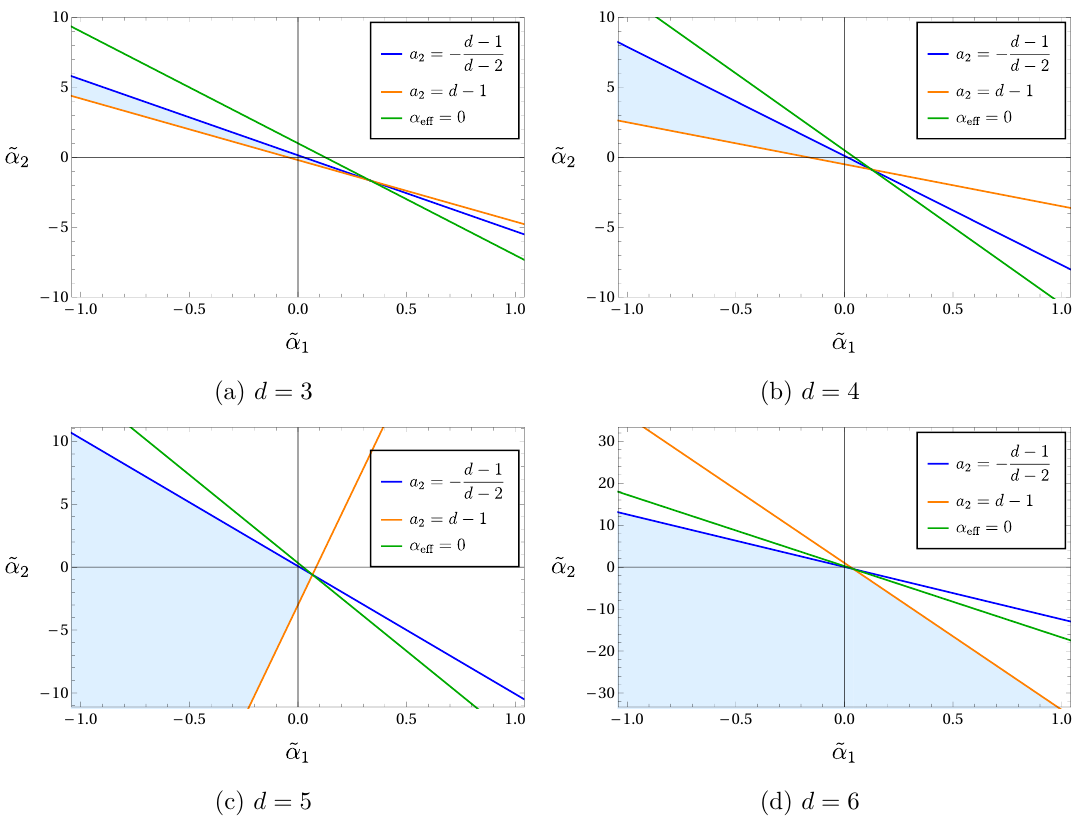
Figure 1. Bounds in the constants ˜ α 1 = f ∞ α 1 and ˜ α 2 = f ∞ α 2 obtained from unitarity and positivity of energy fluxes, given by (5.5), (5.8) and (5.9), in different dimensions. The allowed region in each case is shaded in blue, and is infinite. For any d > 6 the allowing region looks qualitatively similar to that obtained for d = 6